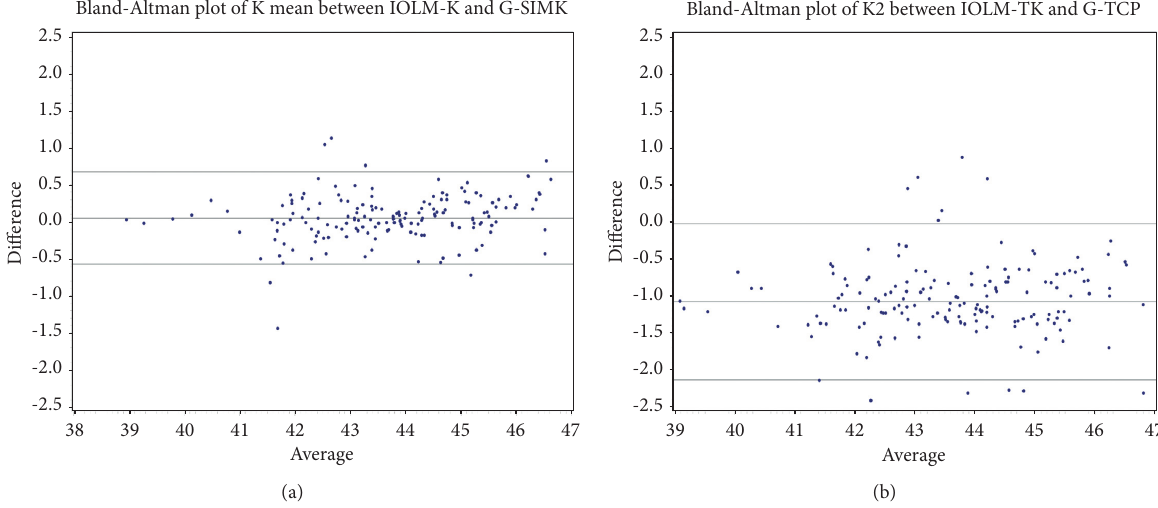
Figure 2: Bland–Altman plots depicting interdevice agreement in primary endpoints mean SimK (a) and mean True K (b). Horizontal lines depict mean ± 1.96 standard deviation (95% LOA) values. X -axis � mean corneal power (D). Y -axis � difference in mean value (Galilei-